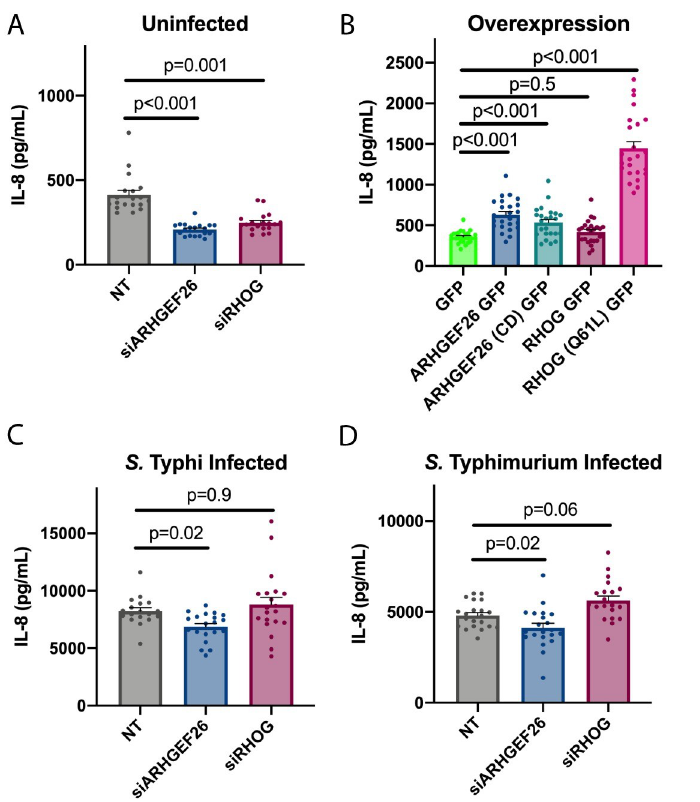
Fig 8. ARHGEF26 and RHOG are context-dependent enhancers of IL-8 abundance in HeLa cell supernatant. (A) ARHGEF26 and RHOG knockdown results in less IL-8 secretion into HeLa cell supernatant than non-targeting (NT) siRNA. Media was changed two days post transfection and supernatant was collected 8 hours later. (B) Overexpression of ARHGEF26 and RHOG in HeLa cells increases IL-8 cytokine abundance in supernatant. Media was changed on transfected cells 18–24 hours post transfection and supernatant was collected 6 hours later. (C, D) ARHGEF26 , but not RHOG , knockdown reduces IL-8 abundance in supernatant following S . Typhi infection (C) and S . Typhimurium infection (D). For C and D, cells were infected two days post transfection. Cells were infected with S . Typhi (MOI 30) or S . Typhimurium (MOI 1) for one hour before gentamicin addition. Media was changed two hours before infection and supernatant was collected six hours after infection. Cytokine abundance was measured by ELISA. For all graphs, dots represent a single well and data were collected across seven independent experiments. Data were normalized to the grand mean prior to plotting or performing statistics. For (C), two outliers identified by ROUT (Q = 0.1%) were removed from the non-targeting group. These values (17,924 pg/mL and 22,083 pg/mL) inflated the mean of the NT group, making the ARHGEF26 effect size artificially large, and the p-value artificially low (p = 0.002). P-values were calculated using a one-way ANOVA with Dunnett’s multiple comparison test on the log 2 transformed data. For all graphs central tendency is the mean, error bars are the standard error of the